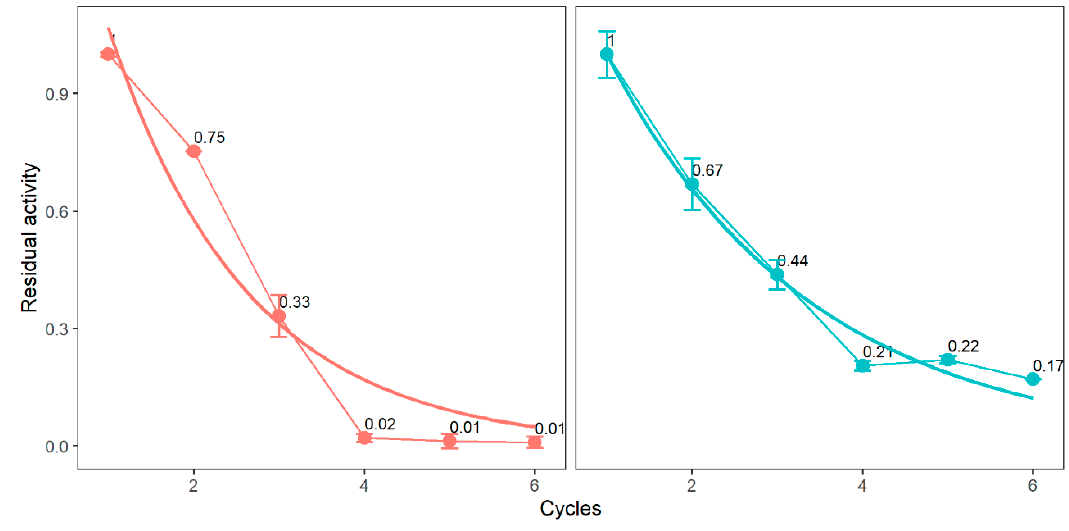
Figure 6. Deactivation profile of ENZ-ionogel-20,100G in hexane at 70 °C.